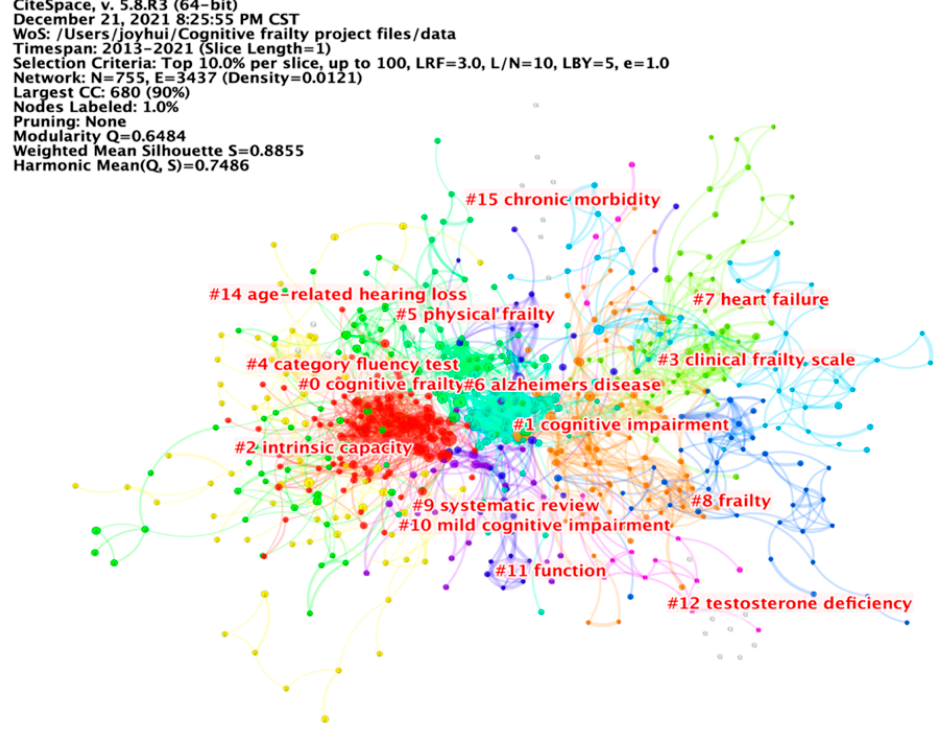
Figure 5. Document co-citation network in cognitive frailty research. A total of 69,148 valid references were extracted, and a network consisting of 755 nodes and 3437 links was visualized. The largest three clusters were cognitive frailty, cognitive impairment, and intrinsic capacity. Table 2. Fifteen representative references in terms of citations, centrality, and